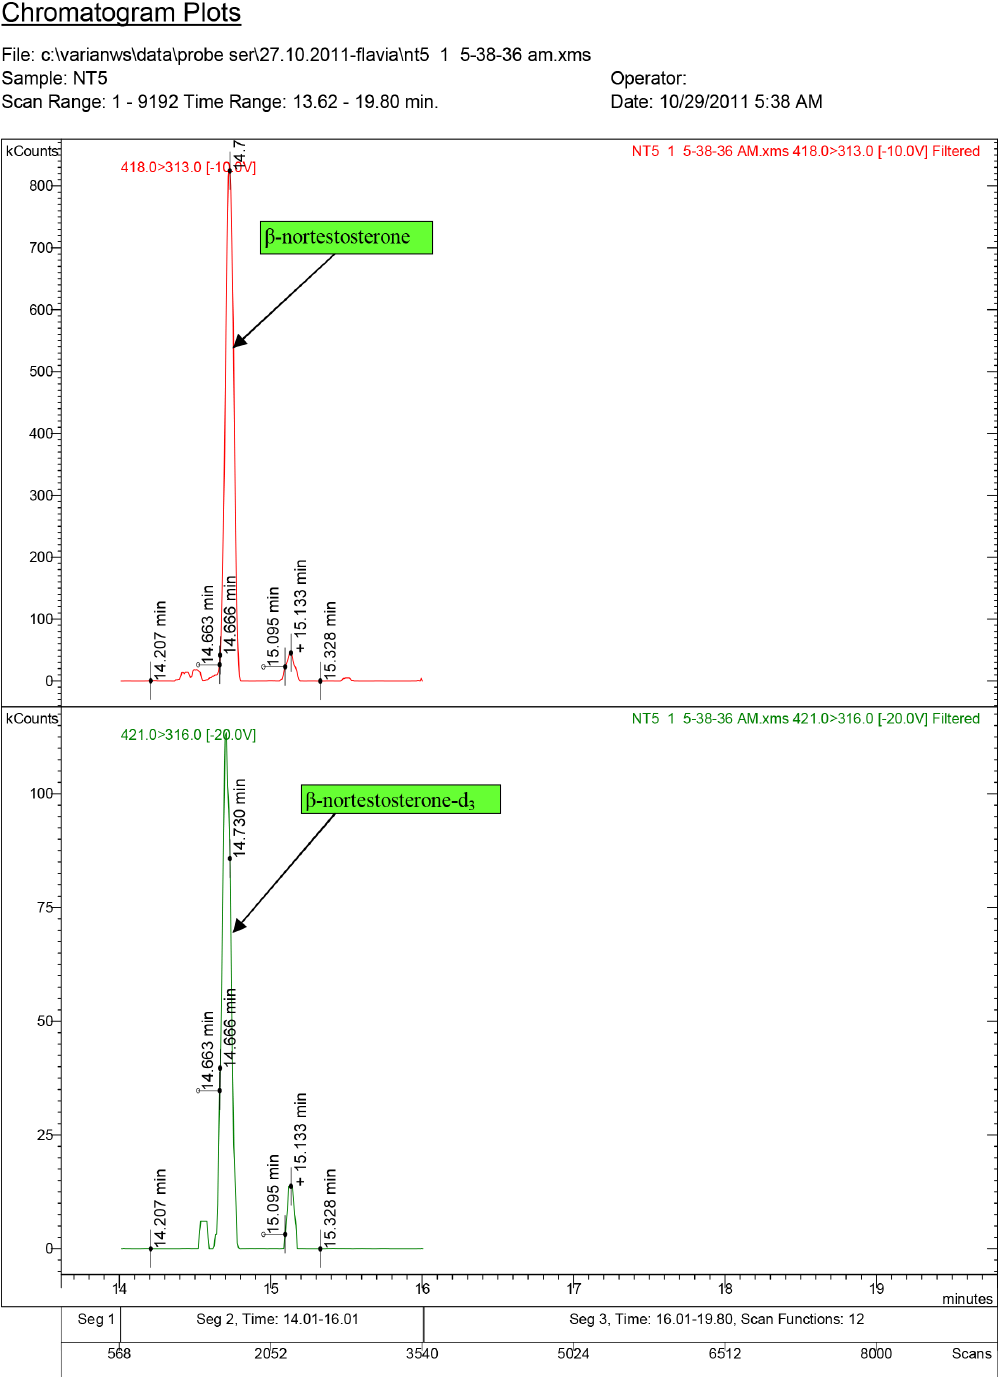
Figure 11. Diagnostic ions for serum sample NT5, where 17 b -nortestosterone was quantified at 4.22 ng/ml (ND2 dose: 7.5 mg/ kg.bw).